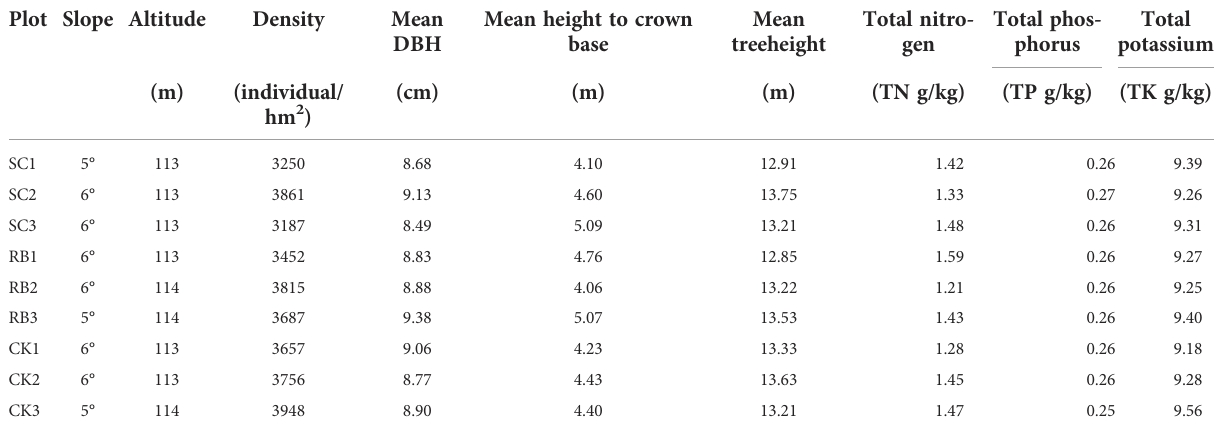
TABLE 1 Basic information of sample plots. Plot Slope